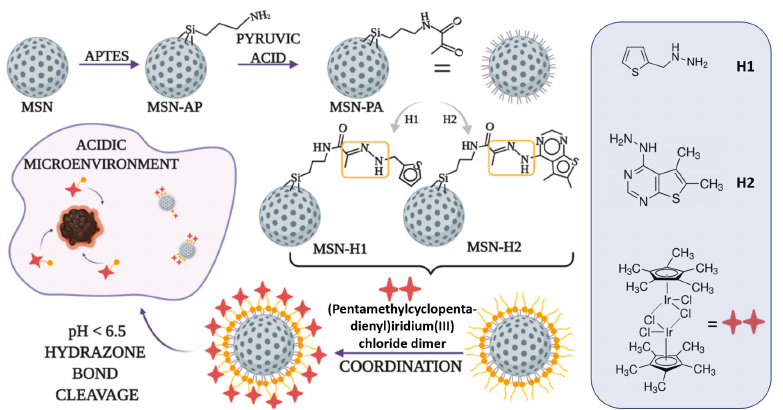
Figure 1. Schematic representation of functionalization of MSN with ligands (H1 and H2), and coordination of the (pentamethylcyclopentadienyl)iridium(III) chloride dimer.